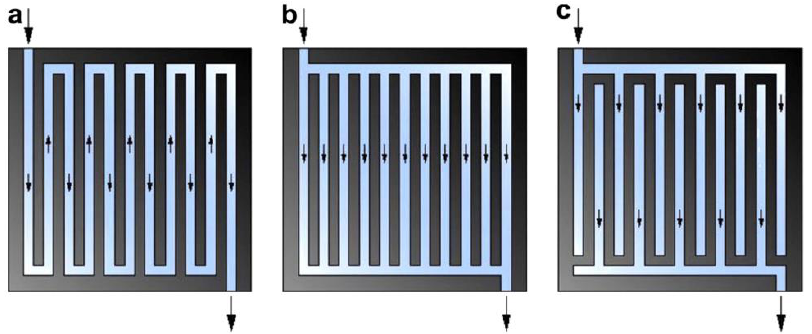
Figure 12. Shape design examples of BP channels [35]. ( a ) serpentine channels | ( b ) parallel channels | ( c ) interdigitate channels.